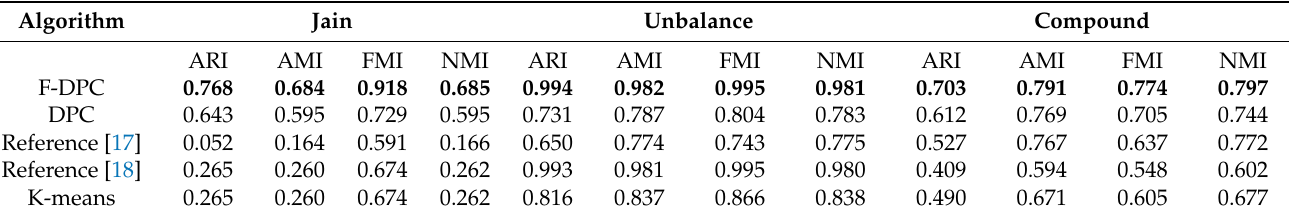
Table 1. Evaluation of clustering indicators for each dataset.